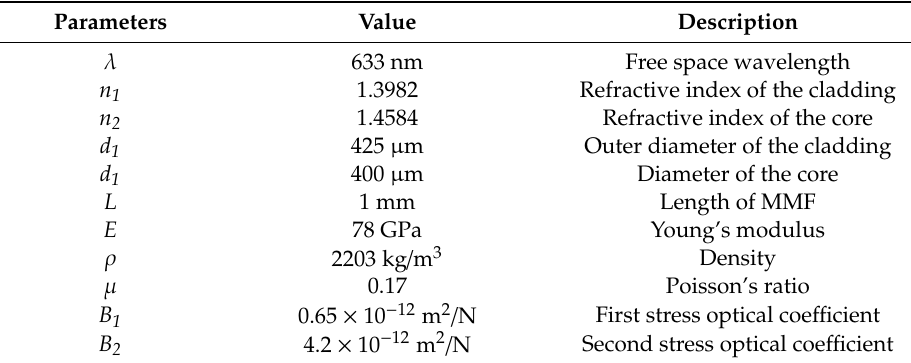
Table 1. The parameters in